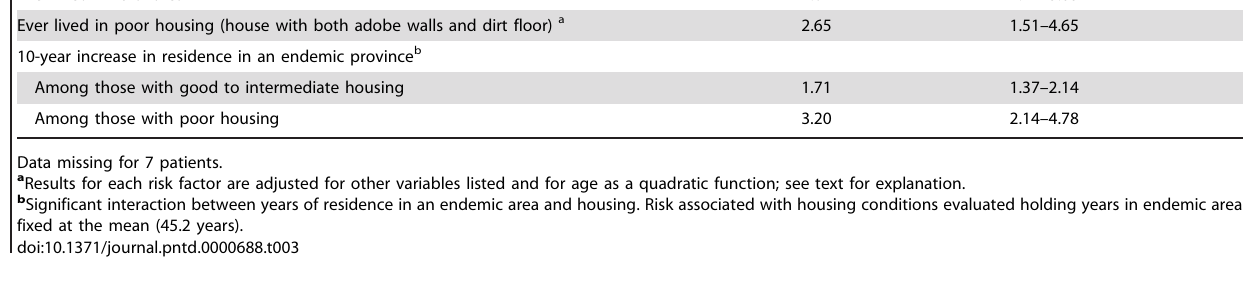
Risk Factors a Odds Ratio 95% Confidence Intervals Gender (male vs.